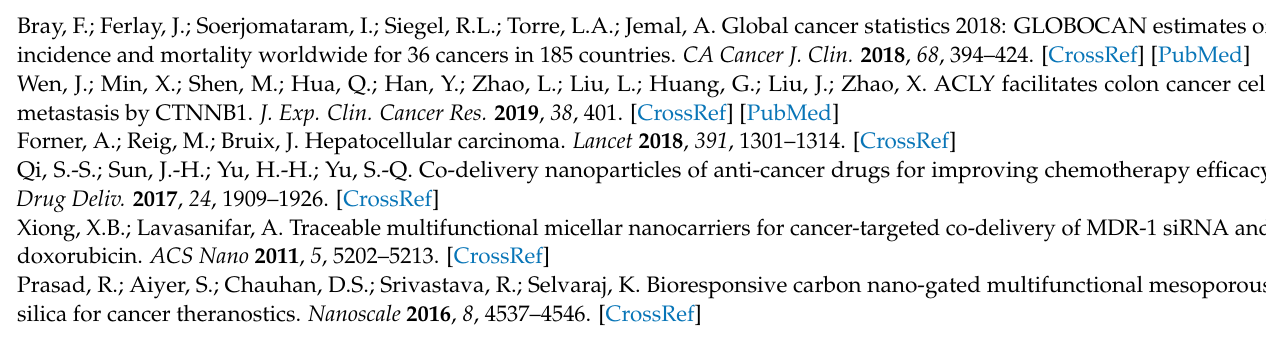
Figure 11. Fluorescence images of cells treated with MSN-NH 2 -Coumarin-6-AOS for 30 min ( a ) and 1 h ( b ).